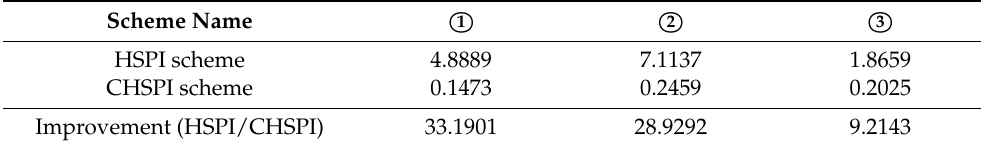
Table 1. Position Coordinate Variance in the Two